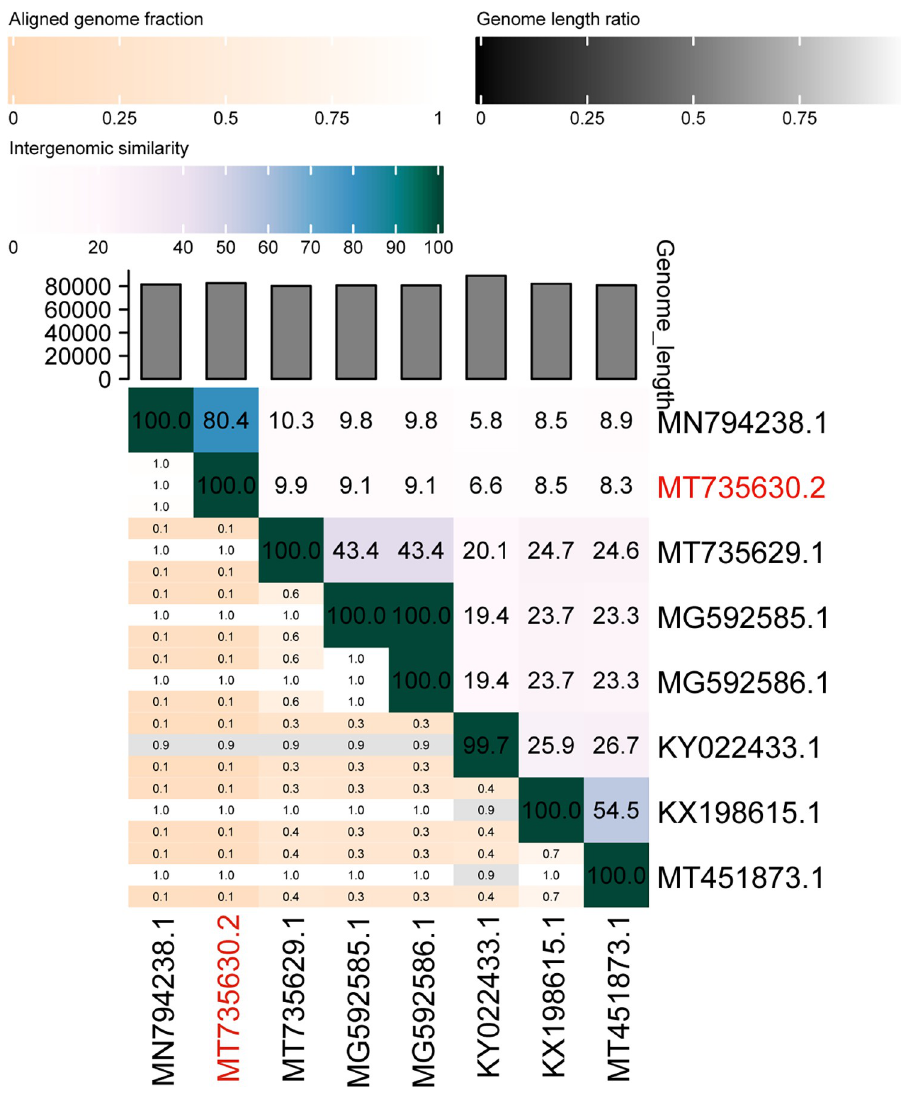
Fig 5. Percent sequence similarity between phages calculated using VIRIDIC. The horizontal and vertical coordinates indicate the corresponding phage GenBank Accession number, and the phage in this study is marked in red